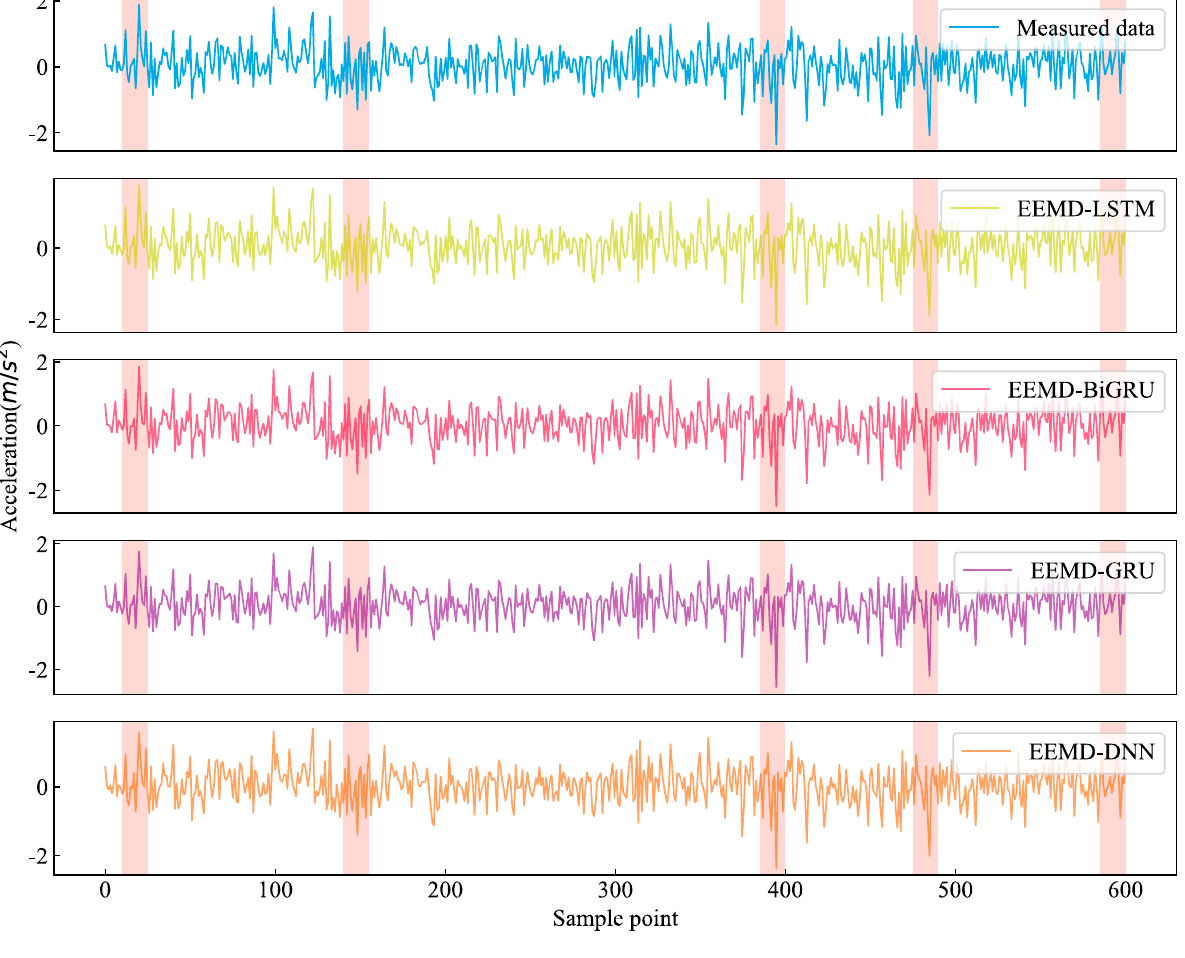
Figure 12. Comparison of the imputations with the four EEMD-based models.